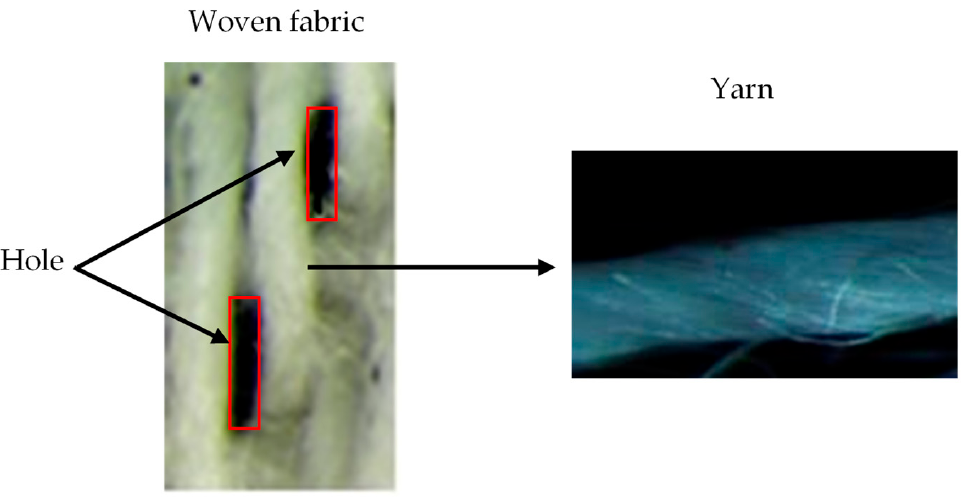
Figure 3. The holes and the non-hole parts of woven fabric are formed by the yarns. As shown in Figure 4, the MPP woven fabric-based system is realized by placing woven fabric in front of the air cavity layer, where a specification of woven fabrics is described in Table 1. In this study, the air cavity depth between the woven fabric and the impervious layer is set to 15